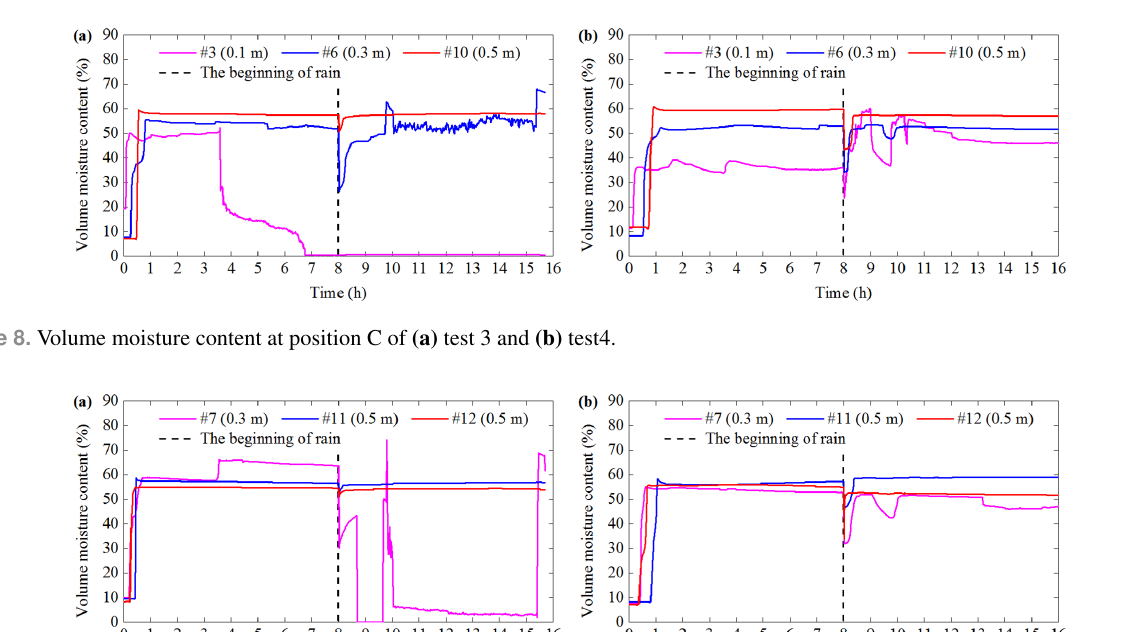
Figure 7. Volume moisture content at position D and E of (a) test 1 and (b) test 2.